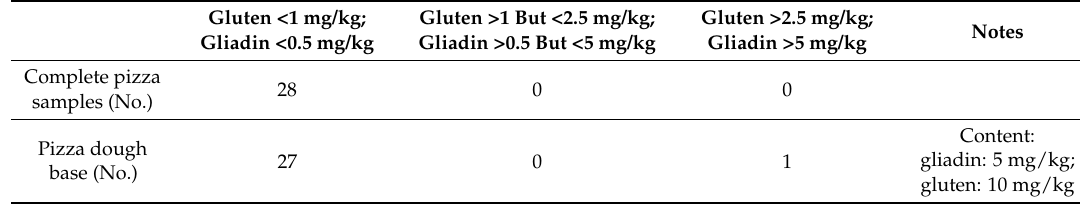
Table 1. Results of gliadin/gluten analysis of Margherita